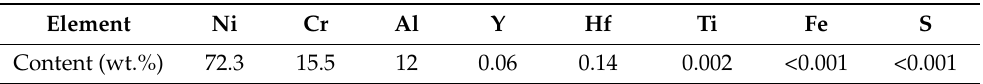
Table 1. The chemical composition of the free-standing NiCrAlYHf alloys (wt.%). Element Ni Cr Al Y Hf Ti Fe S Content